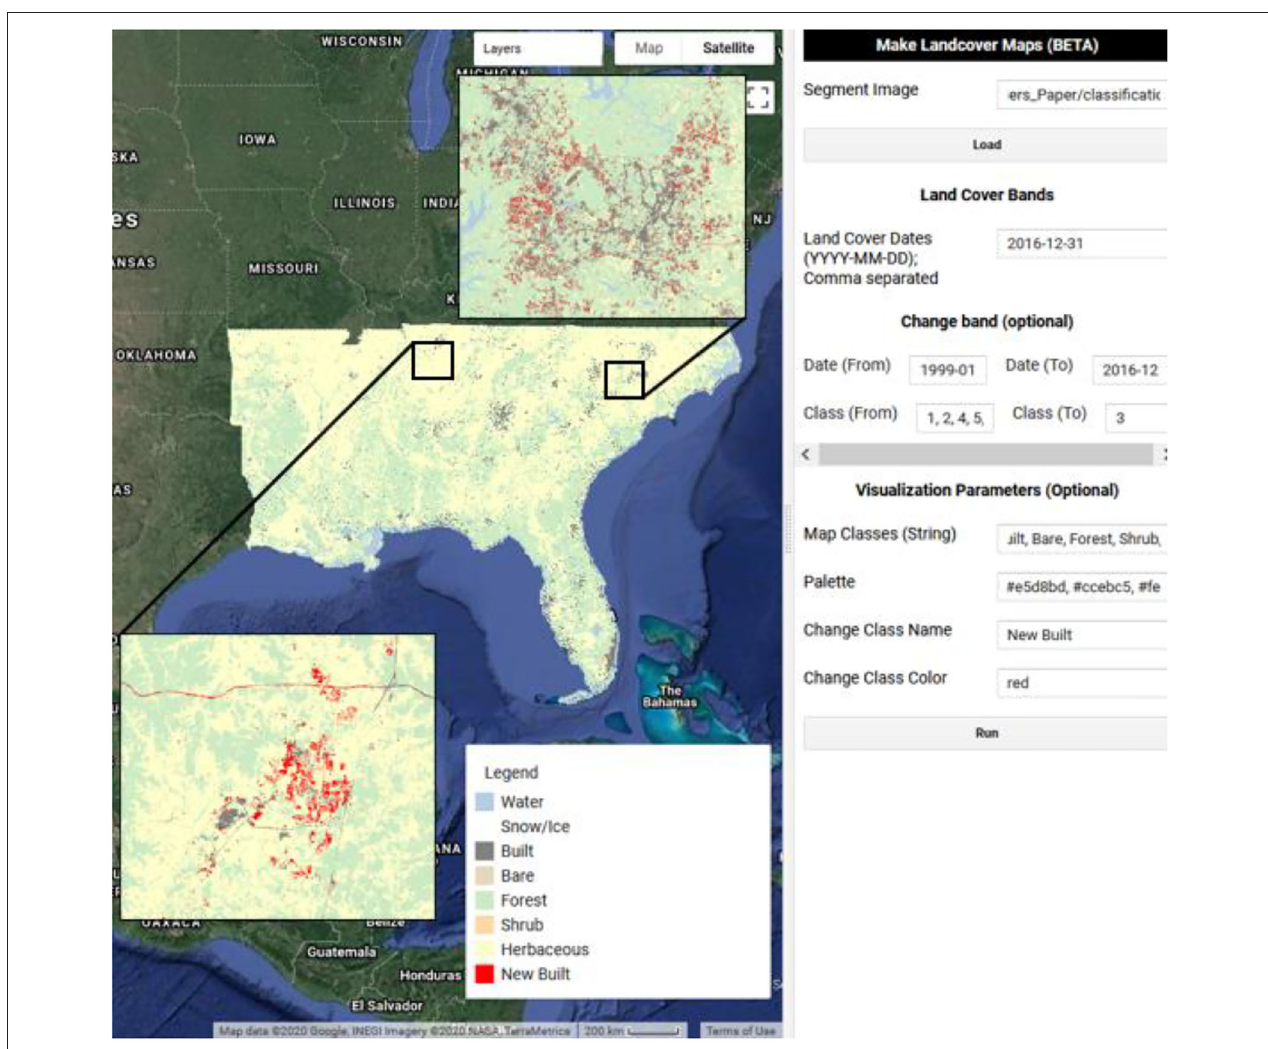
FIGURE 10 | Screenshot of the Land Cover Tool used to display the land cover classification at the end of 2016 and conversion to Built land (“New Built”). Insets detailing some of the largest change areas were manually overlayed for display in this